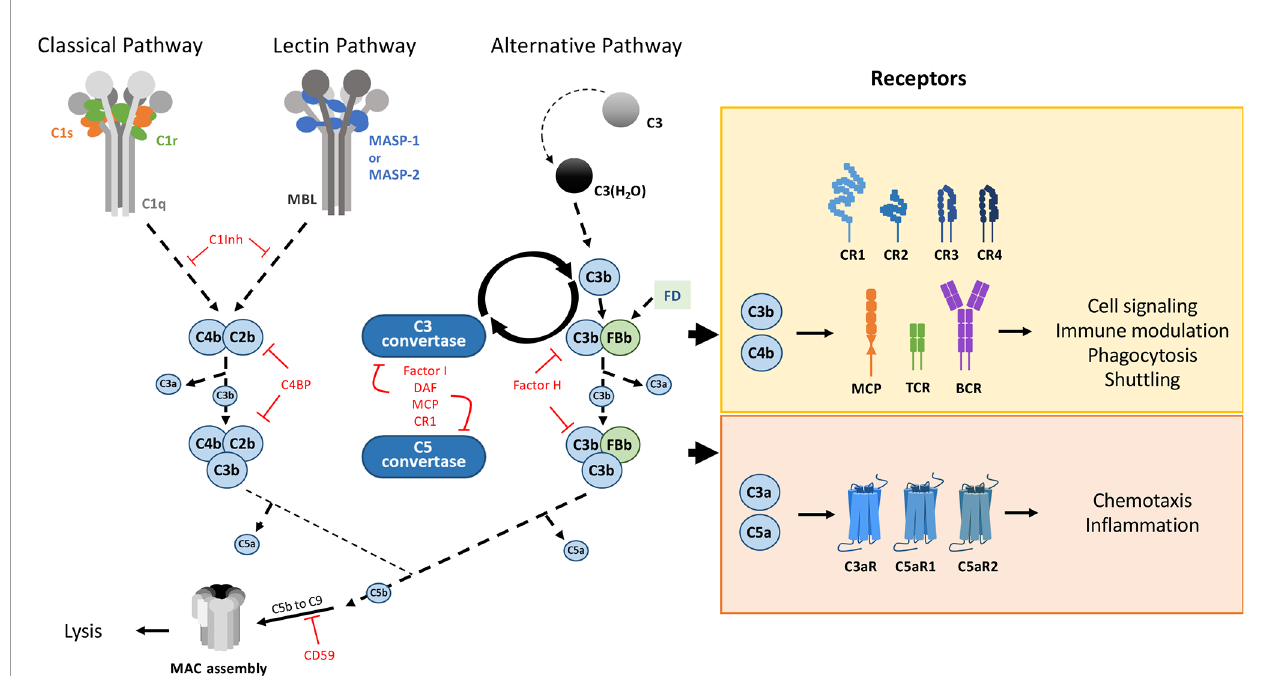
FIGURE 2 | The complement system main pathways and ‘ classical ’ canonical functions. Triggered by proteolytic cascades, this defense system gets activated and ampli fi ed ‘ on site ’ , raising alarm signals through different speci fi c receptors, under the control of numerous regulators. The classical pathway (CP) and lectin pathway (LP) are activated by the C1 complex and the collectin-MASPs complexes, respectively. Collectins (CL) are pattern recognition molecules with collagen-like domains that recognize speci fi c carbohydrate or acetylated surface motifs: MBL, fi colins or collectins recently discovered in the liver (CL-10), kidney (CL-11) or placenta (CL-12) (4). By cleaving C4 and C2, C1s (CP) and MASP-2 (LP) generate a C3 convertase. The (AP) is activated by the spontaneous hydrolysis of C3. All three pathways lead to the formation of the C3 convertase (C4b2b for CP and LP and C3bBb for AP), thus cleaving C3 into C3a and C3b. The ampli fi cation loop of the AP C3 convertase leads to massive C3b deposition, covalently bound to the surfaces, targeting them for phagocytosis. The cascade further proceeds to the formation of the C5 convertase, which allows the formation of the Membrane Attack Complex (MAC) on the target surface leading to its lysis. The complement cascade is modulated by various inhibitors (C4BP, C1inh), regulators such as factor H (FH), factor I (FI) that destabilize the C3 convertase (FH, DAF) or cleave C3b (FI assisted by CR1 and MCP (CD46) co-factors). Other regulators limit the fi nal MAC assembly, such as CD59, vitronectin, clusterin … Almost all fragments produced by this enzymatic cascade are bioactive. The C3a and C5a anaphylatoxins mediate chemotaxis and in fl ammation through their respective receptors, C3aR and C5aR1, C5aR2. Receptors involved in immune modulation depend on the immune cell: CR1, CD46 and TCR on T cells, CR2 and BCR on B cells, recognizing inactivated C3b derivatives. CR1/2/3/4 are also involved in adhesion/ shuttling from red blood cells towards the liver and spleen, for example. Only the cleavage products are shown on this simpli fi ed scheme, and they follow here the recent recommendation regarding C2 nomenclature (5). Molecule schemes are not adjusted to the same